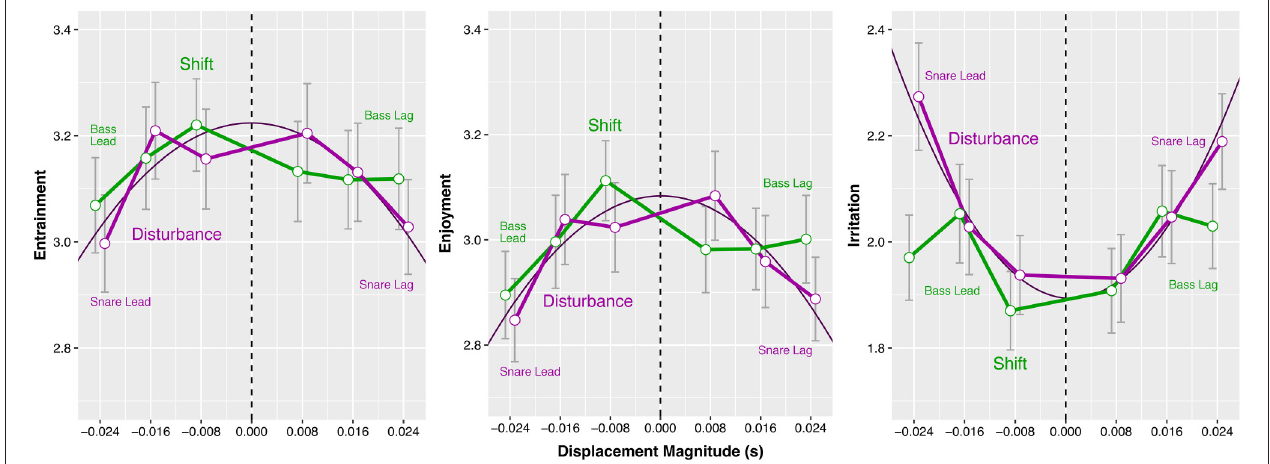
FIGURE 3 | Study A : Effects of Displacement Magnitude (in seconds) on mean Entrainment , Enjoyment , and Irritation ratings, separated by microtiming manipulation method ( Shift in green, Disturbance in purple). Error bars represent the standard error of the